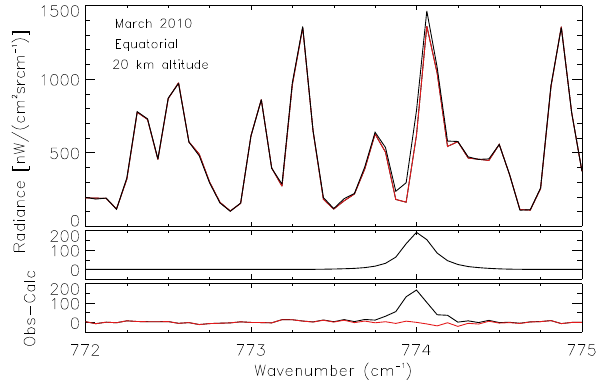
Figure 2. Top panel: an averaged MIPAS radiance spectrum (in black) for equatorial measurements (3547) taken in March 2010 covering the 772–775cm − 1 microwindow and interpolated to 20km altitude; in red is the averaged calculated spectrum with- out the inclusion of COF 2 in the forward model. Second panel: the calculated COF 2 contribution to the spectrum. Bottom panel: the observed–calculated residuals for the retrieval, with and with- out COF 2 included in the forward model (in red and black, respec- tively). Table 4. Interferers in the MIPAS carbonyl fluoride